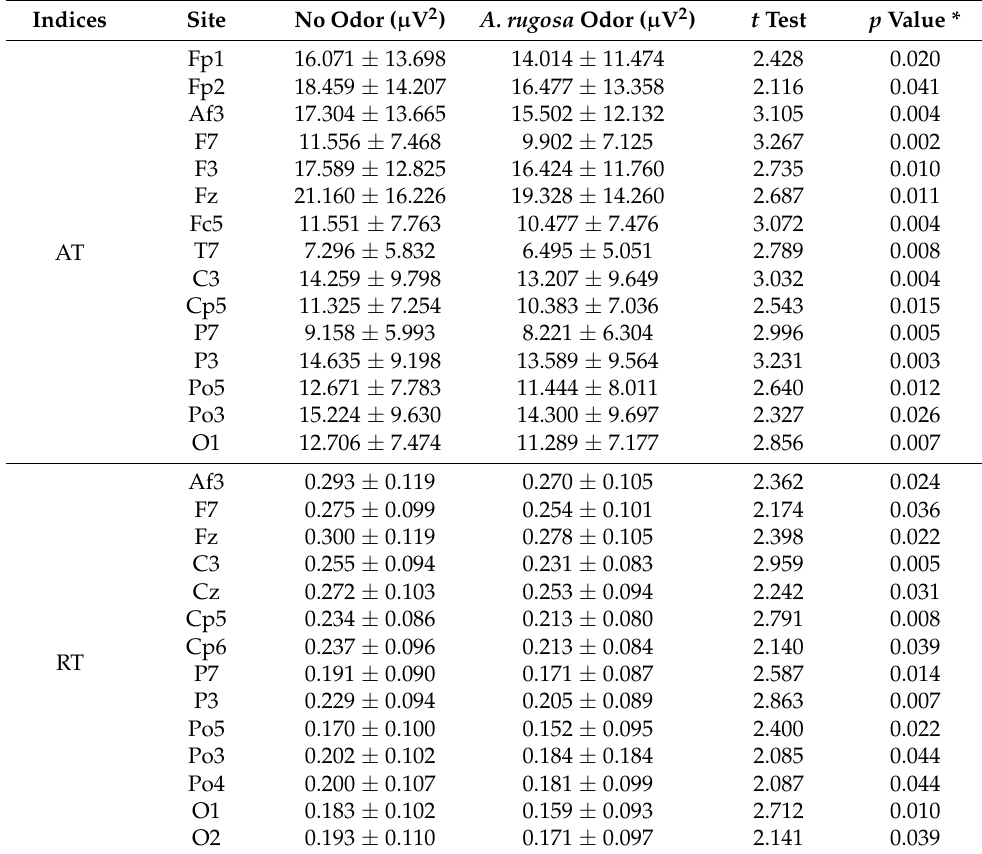
Table 3. Significant changes of AT and RT power spectra between no odor exposure and A. rugosa essential oil odor